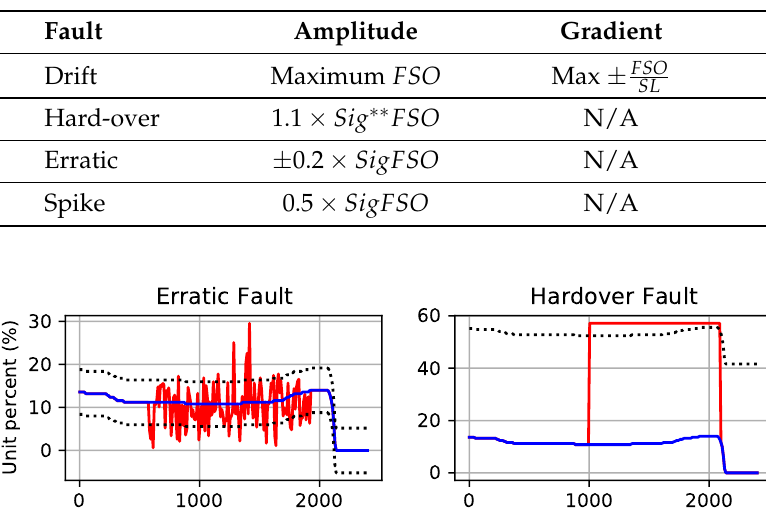
Table 5. Fault parameters. ∗ SL stands for signal length and ∗∗ Sig stands for signal.